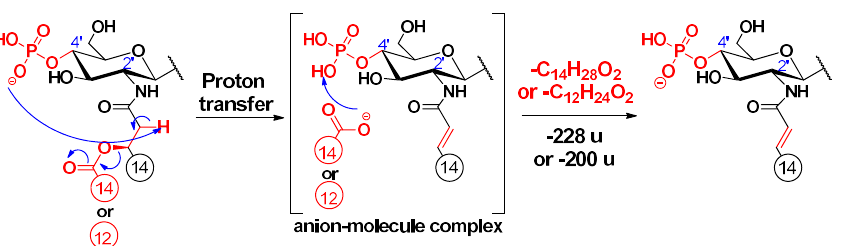
Scheme 3. Proposed fragmentation mechanism for the loss of the C-2’ branched acyl chain (as an